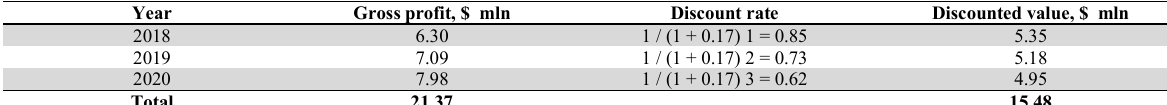
Discounted trust value